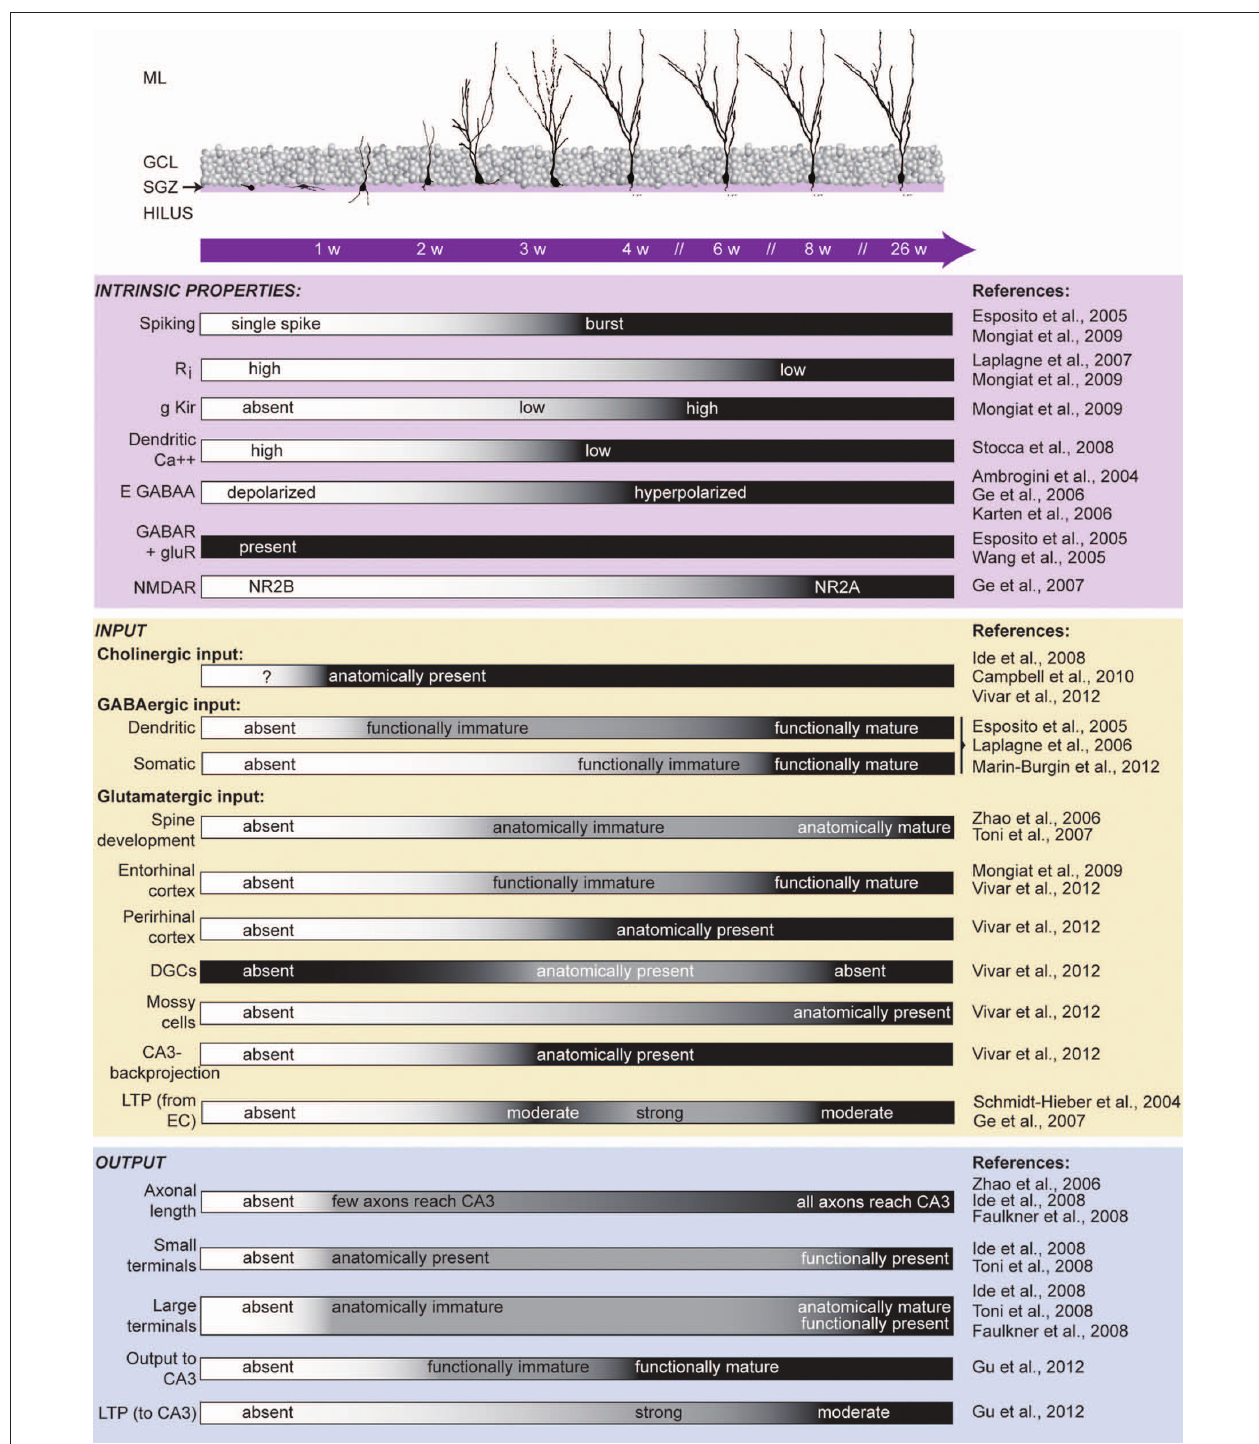
indicates the developmental age when the defined characteristic is indistinguishable between immature and mature DGCs (see primary literature for the specific time points that were included in each experiment). Ri, input resistance; g Kir, inward rectifier potassium conductance; DGCs, dentate granule cells; LTP, long-term potentiation; EC, entorhinal cortex. ML, molecular layer; GCL, granule cell layer; SGZ, sub-granular